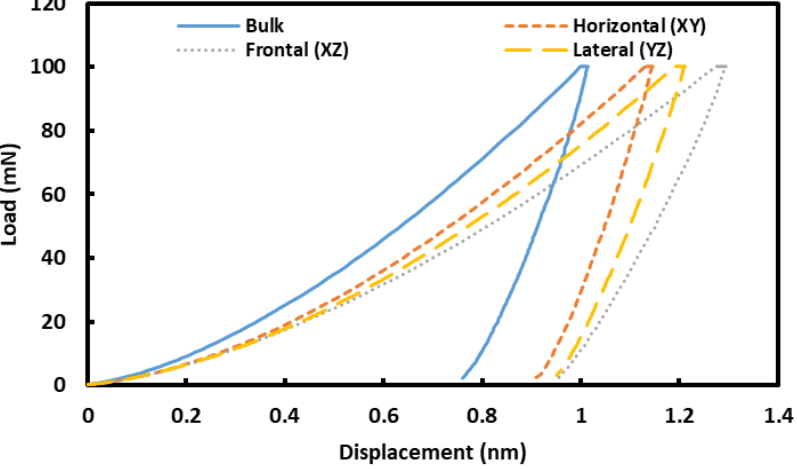
Figure 9. Representative load–displacement graphs on different plans of L-PBF and cast Inconel 718 alloy. 718